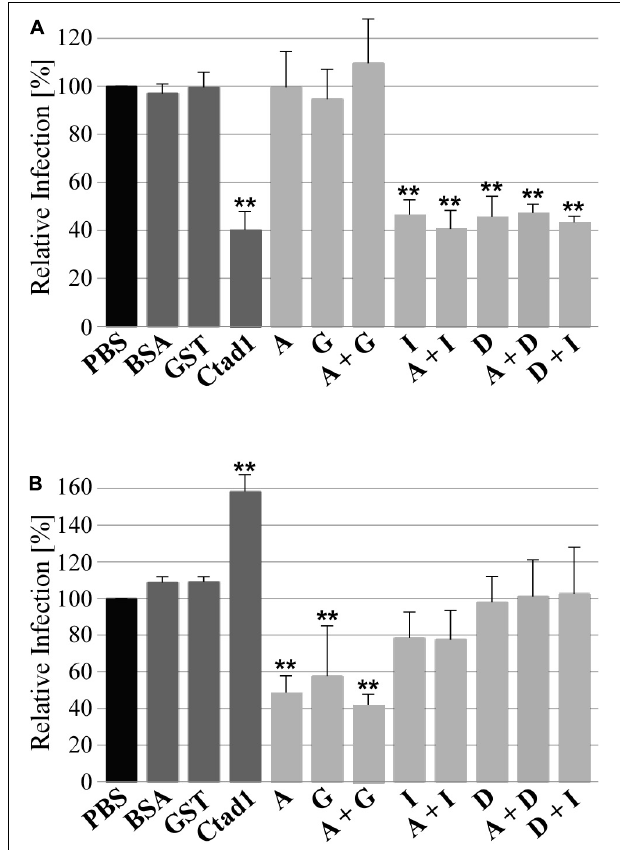
FIGURE 6 | Adhesive homomeric and heteromeric Pmp oligomers are essential for infection. (A) Infection-blocking ability of 200 µ g/ml soluble recombinant homomeric or heteromeric Pmp oligomers (light gray) incubated with human epithelial HEp-2 cells prior to infection with C. trachomatis EBs (MOI 10). (B) Infectivity of C. trachomatis EBs pre-coated with 1 µ M soluble recombinant homomeric or heteromeric Pmp oligomers (light gray) prior to infection of human epithelial HEp-2 cells. BSA, rGST, and rCtad1 were used as controls (dark gray). Infection rates for each condition were determined by counting the number of inclusions in 10 pictures, for a total of 5.8 * 10 3 HEp-2 cells and are expressed as a percentage of the number of inclusions determined by the PBS-treated sample (black) set to 100%. The relative infection rates represent the mean of three separate experiments. P -values were calculated using One-way ANOVA followed by Dunnett’s multiple comparisons test. ** p <